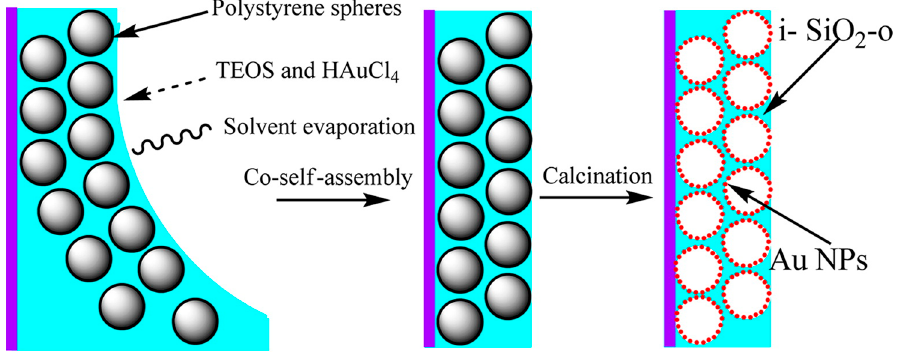
Figure 5. Fabrication of i-Au-SiO 2 -o Films [34].